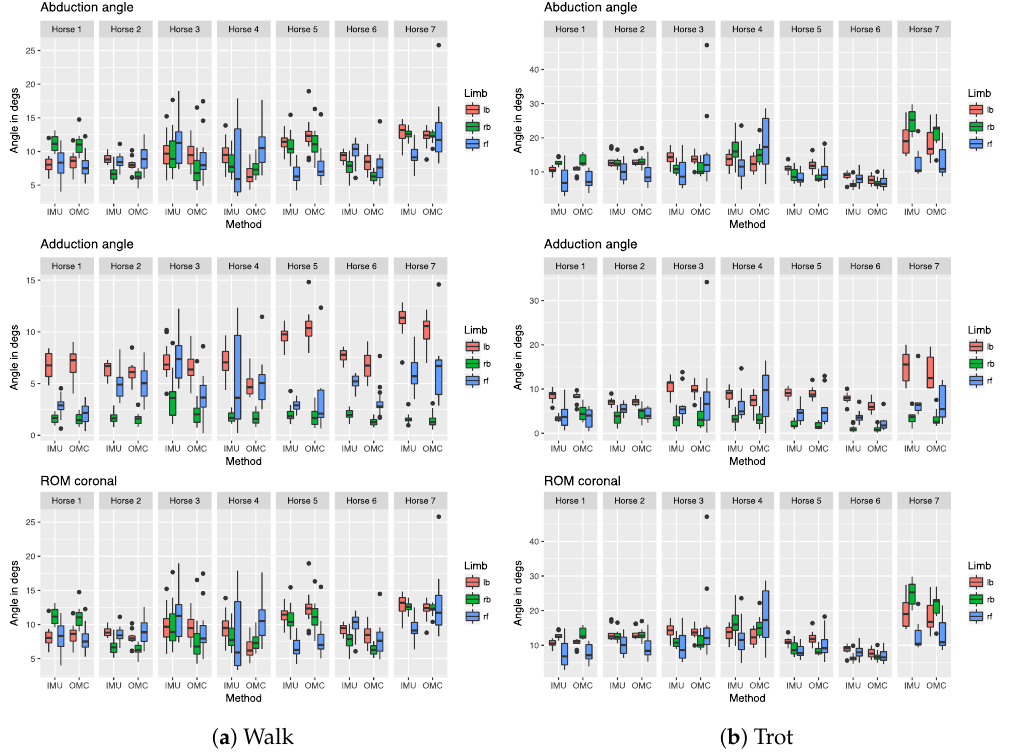
Figure A2. Box plots for the coronal limb angles measured by IMU and OMC.